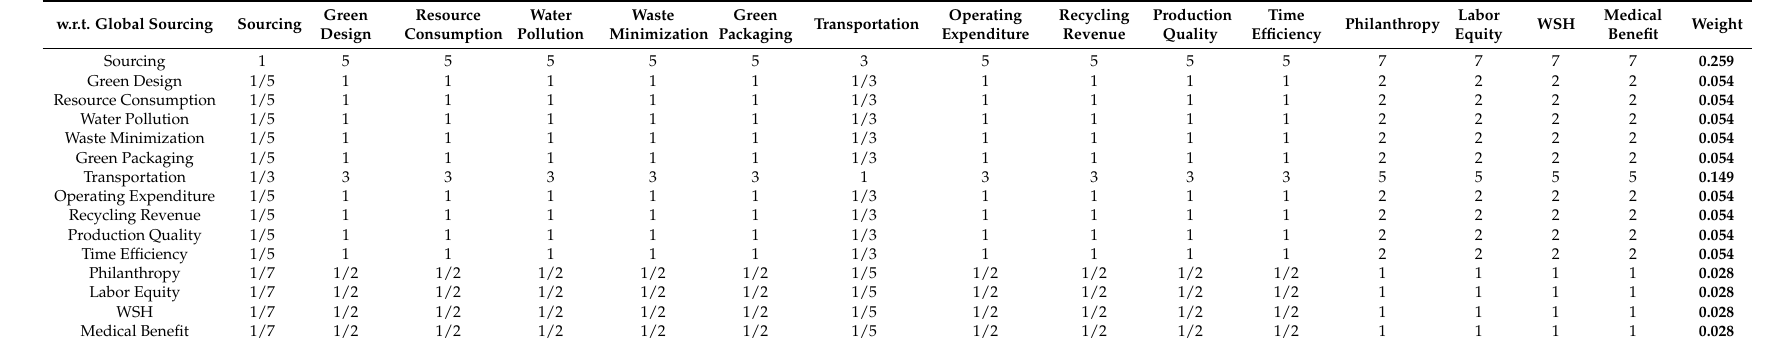
Table 12. Pairwise comparisons of the criteria w.r.t. Global